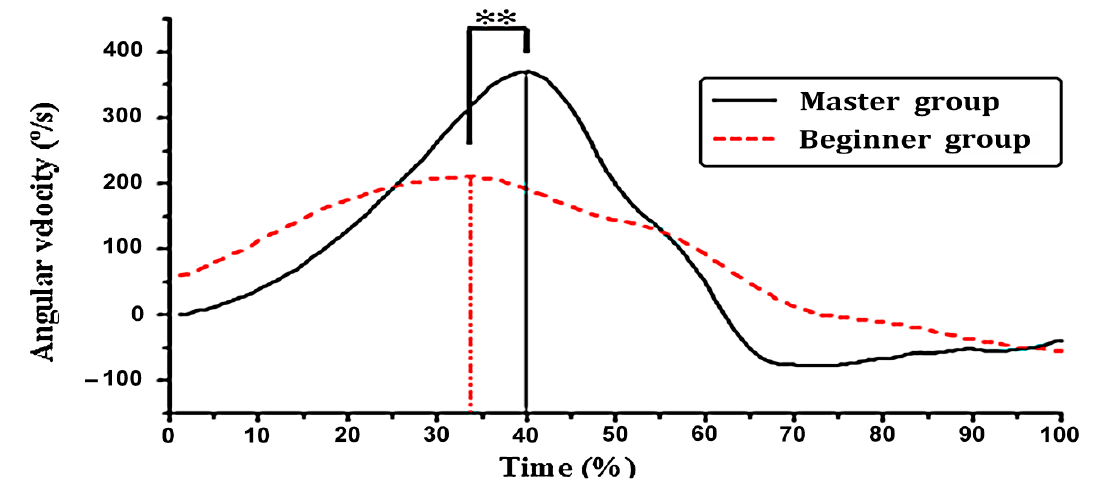
Figure 9. Change in hip joint angular velocity. * indicates p < 0.05, ** indicates p < 0.01.